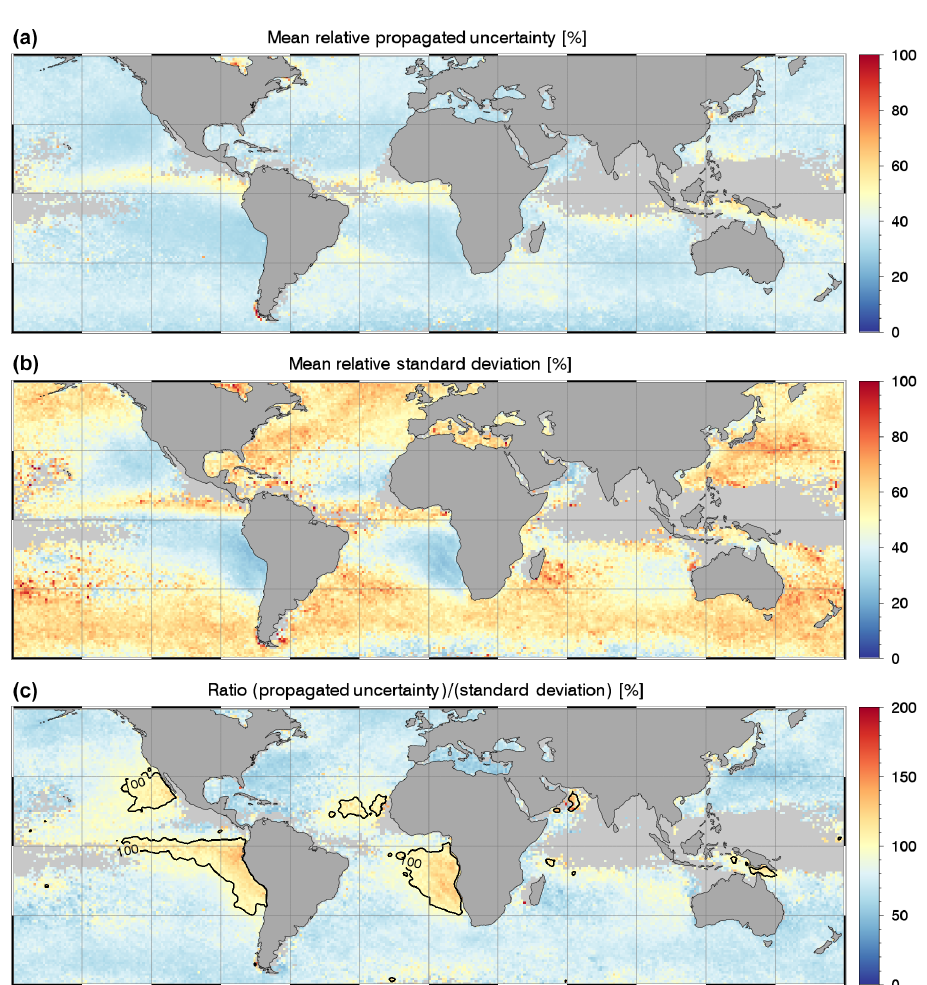
Figure 8. Panel (a) shows the mean uncertainty of the 1 × 1 ◦ CDNC estimates calculated via error propagation based on retrieval errors reported for the MODIS effective radius and optical depth products and following the methodology outlined in Bennartz (2007). Panel (b) shows the mean relative standard deviation of all Level-2 CDNC retrievals that contribute to a 1 × 1 ◦ average. Panel (c) shows the ratio of these two